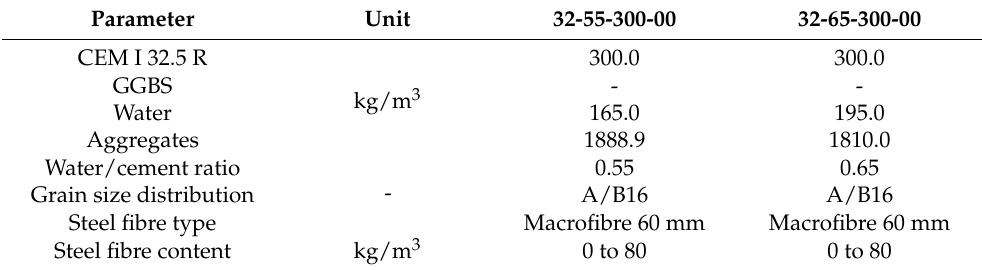
Table A1. Concrete mix designs for the variation of the water/cement ratio.